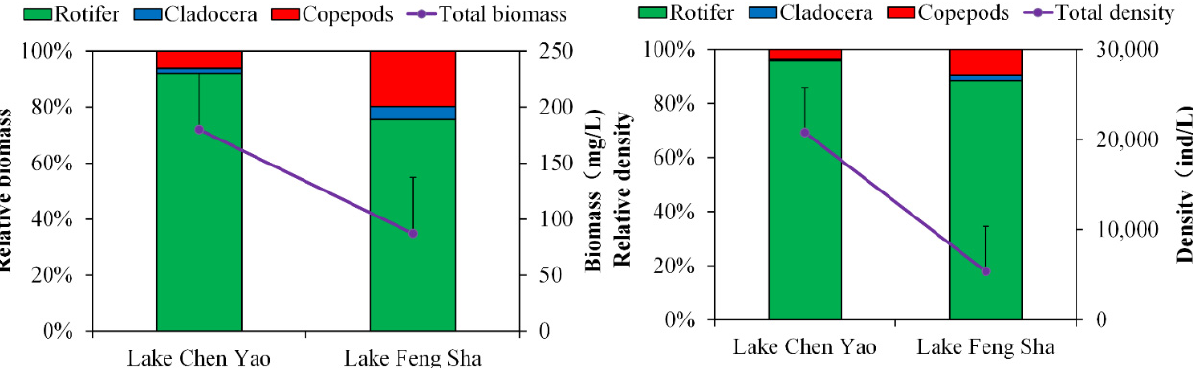
Figure 10. Comparison of biomass and density distribution of zooplankton in Lake Chen Yao and Lake Feng Sha. Table 4. Pearson’s correlation analysis of zooplankton density and biomass with environmental factors in Lake Chen Yao and Lake Feng Sha